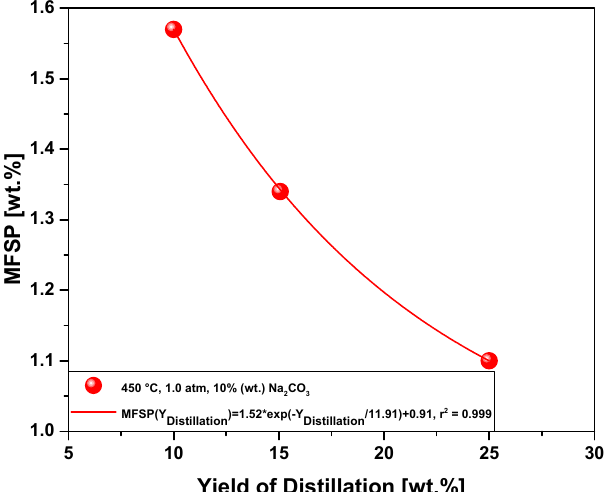
Figure 5. MFSP as a function of bio-oil yield by s ensitivity analysis for a 450 L/day production.